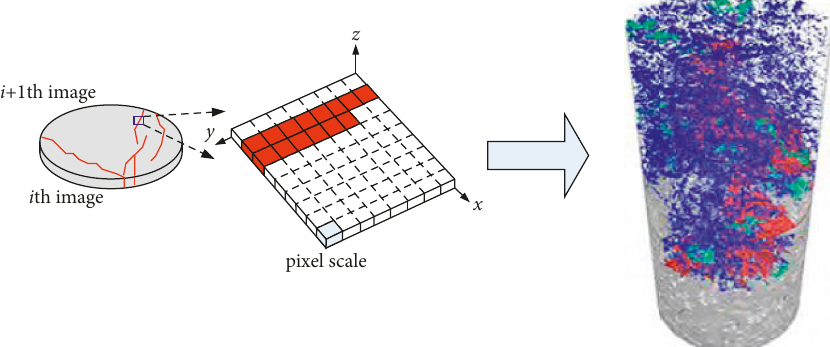
Figure 6: Schematic of three-dimensional reconstruction process of rock.